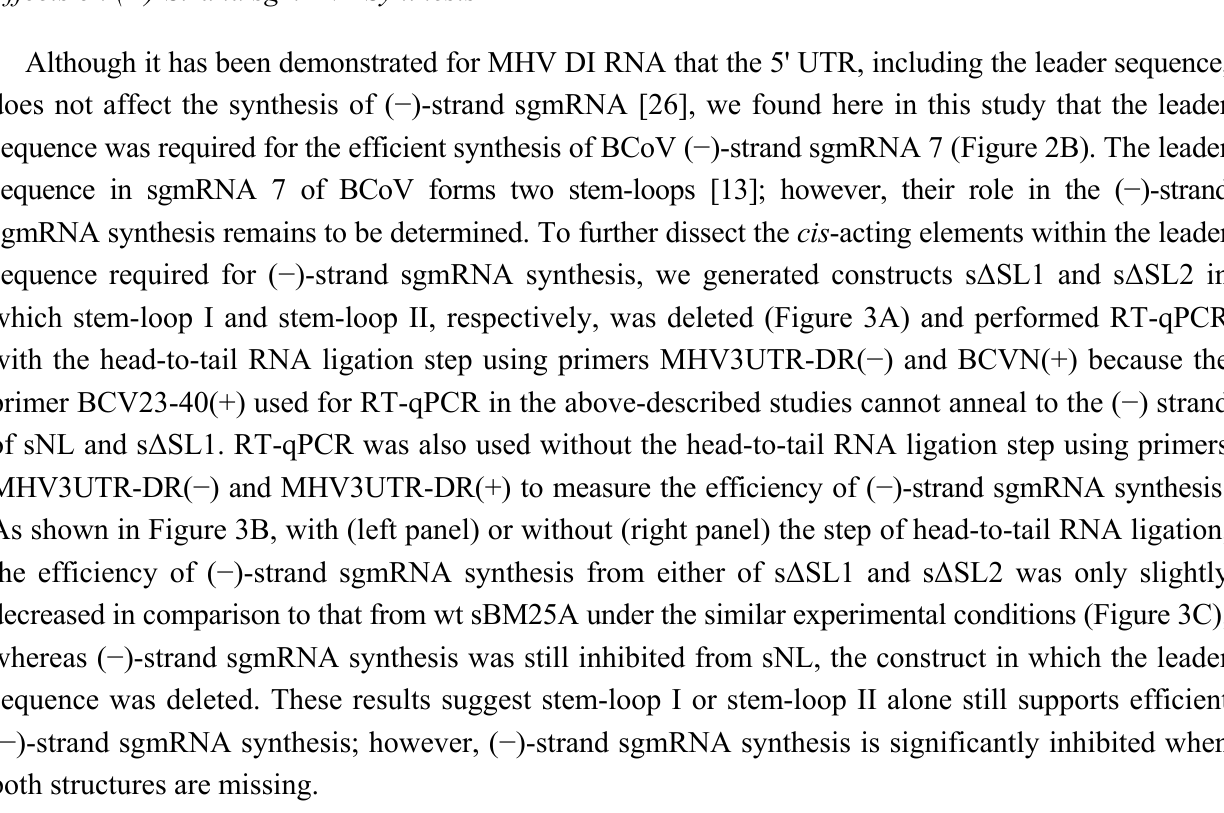
Figure 2. Identification of the cis -acting elements within the 5' and 3' UTRs of